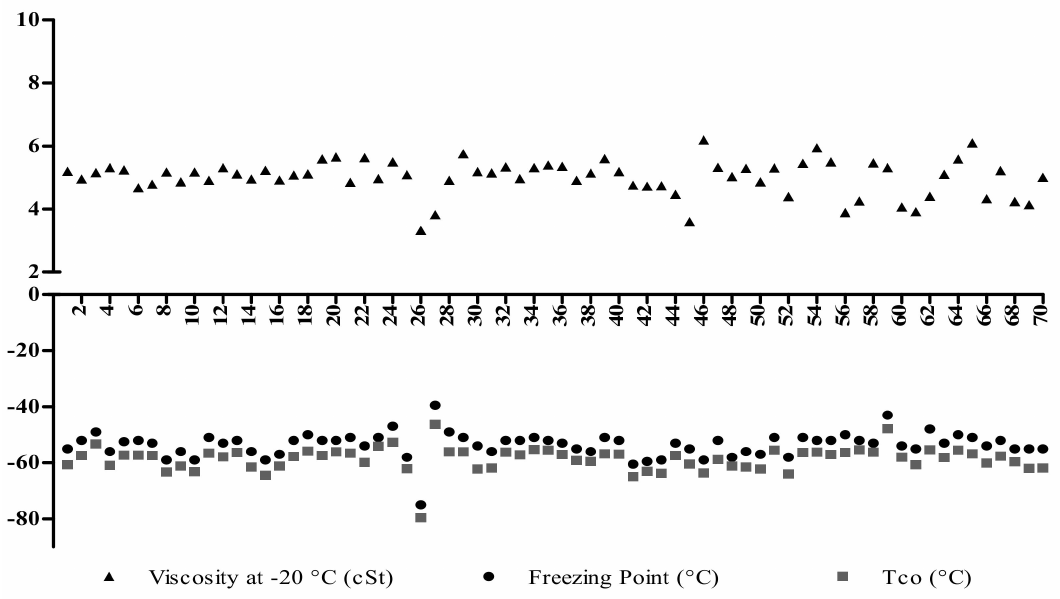
Figure 2. Experimental values of the measured low-temperature fluidity properties.